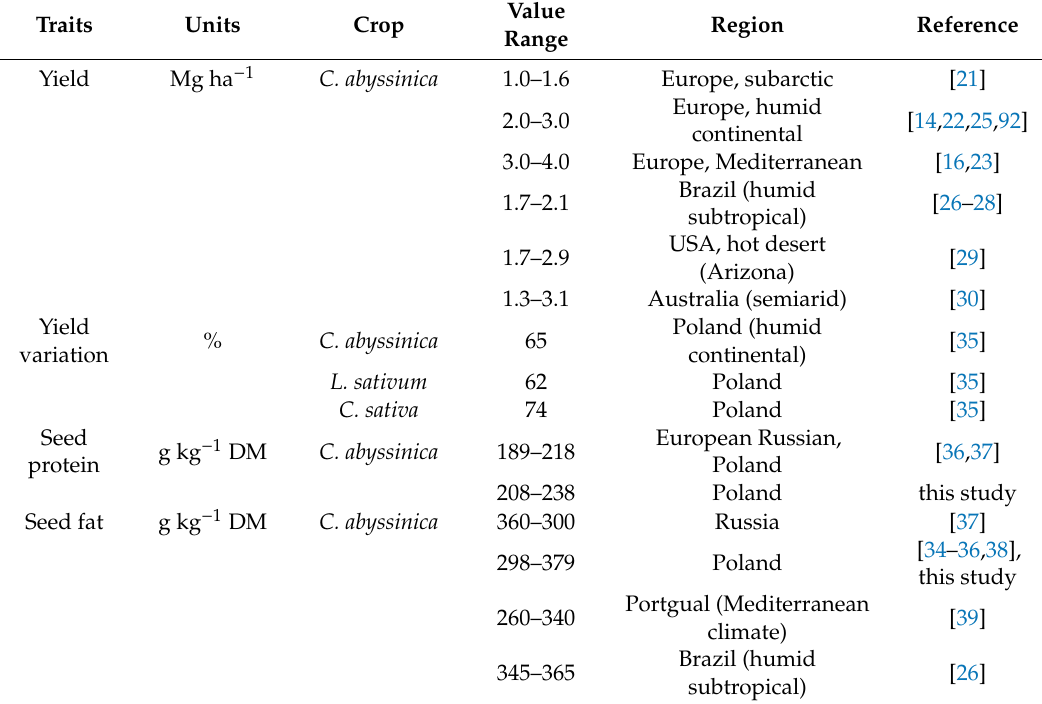
Table 7. Crambe seed yield, seed protein, and oil content, as reported in the literature reviewed.